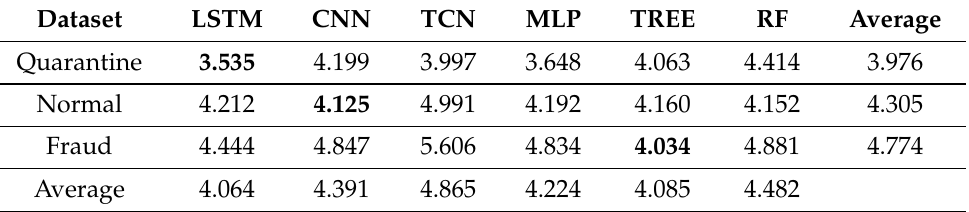
Table 9. MAE results for each period and each model. The results have been obtained after choosing the best set of parameters for each case by carrying out a parameter optimization process. The last row and column correspond to the means for each model and dataset, respectively. The best model for each dataset is specified in bold.